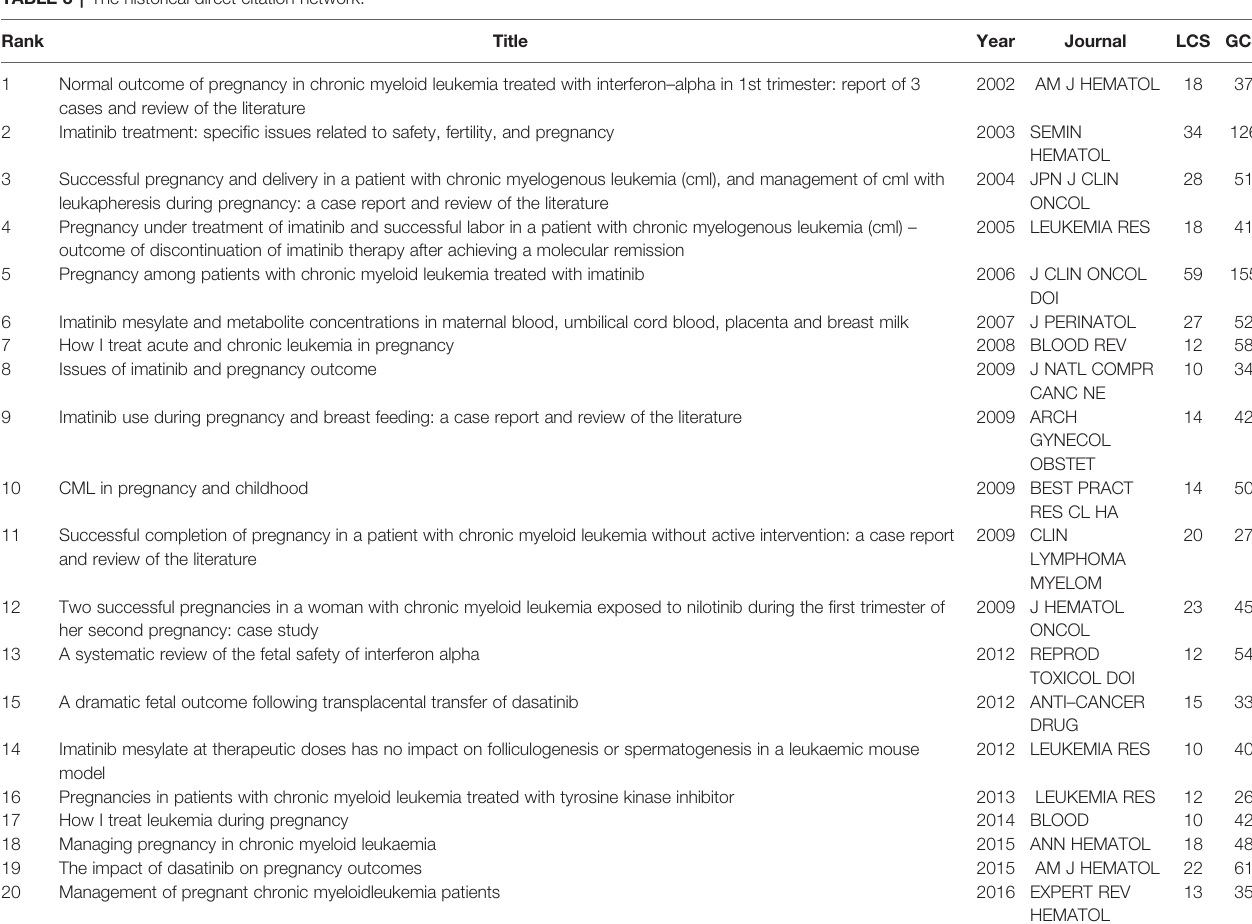
TABLE 3 | The historical direct citation network.